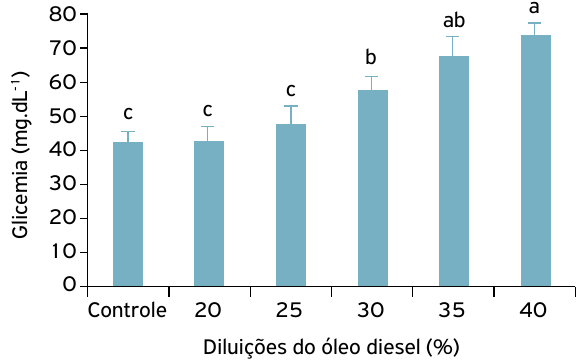
Figura 1. Mortalidade de juvenis de tilápia-do-nilo expostos a diferentes diluições de óleo diesel.